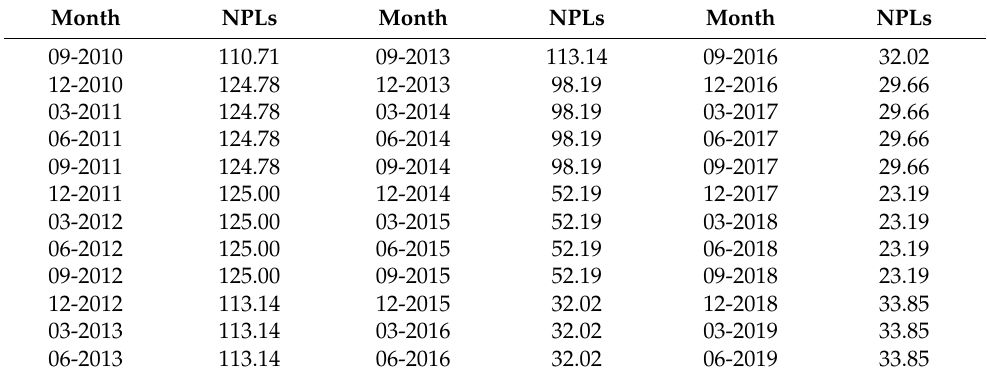
Table 8. Net NPLs in the United Kingdom, in billions of pounds (September 2010–June 2019).